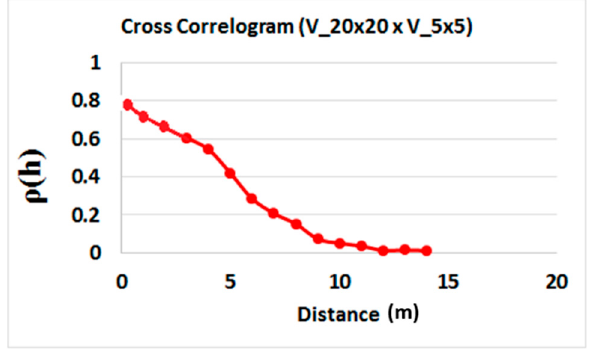
Figure 3. Omnidirectional cross-correlogram for hard data and soft data.